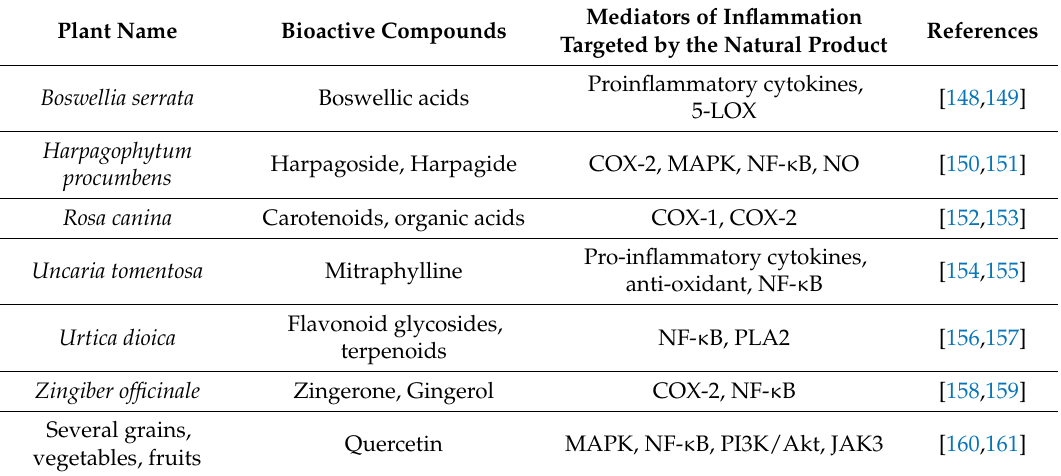
Table 1. Natural products with anti-inflammatory/anti-arthritic